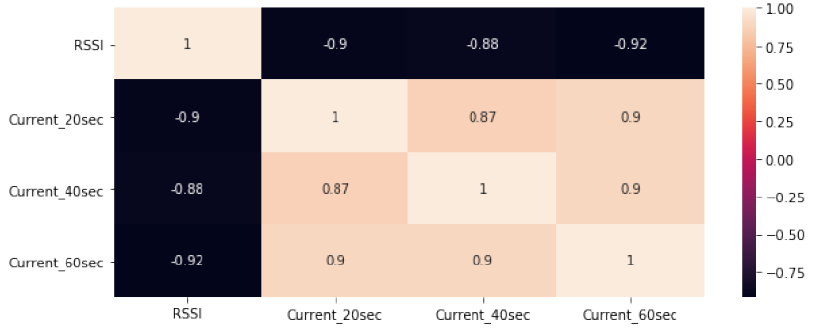
Figure 10. Pearson correlation between RSSI and current variation.